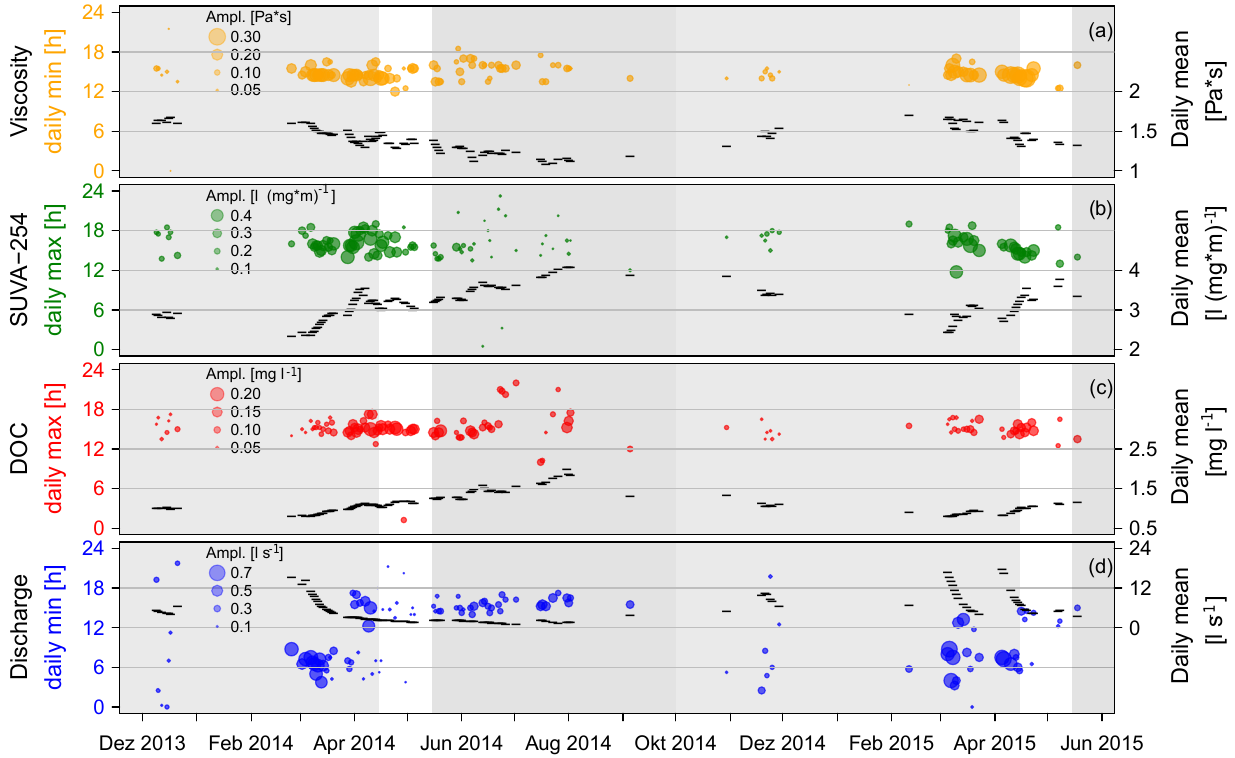
Figure 3. The time of day of the daily minima and maxima of saturated riparian water viscosity, SUVA-254, DOC and discharge over 18 months. Only rainless days with diel fluctuations and without the influence of rainfall–runoff events are represented. The points are scaled by the daily amplitude between the daily minimum and maximum. Black dashes (–) are the daily mean values of the respective variables. Background: dark gray (growing season), light gray (dormant season), white (transition